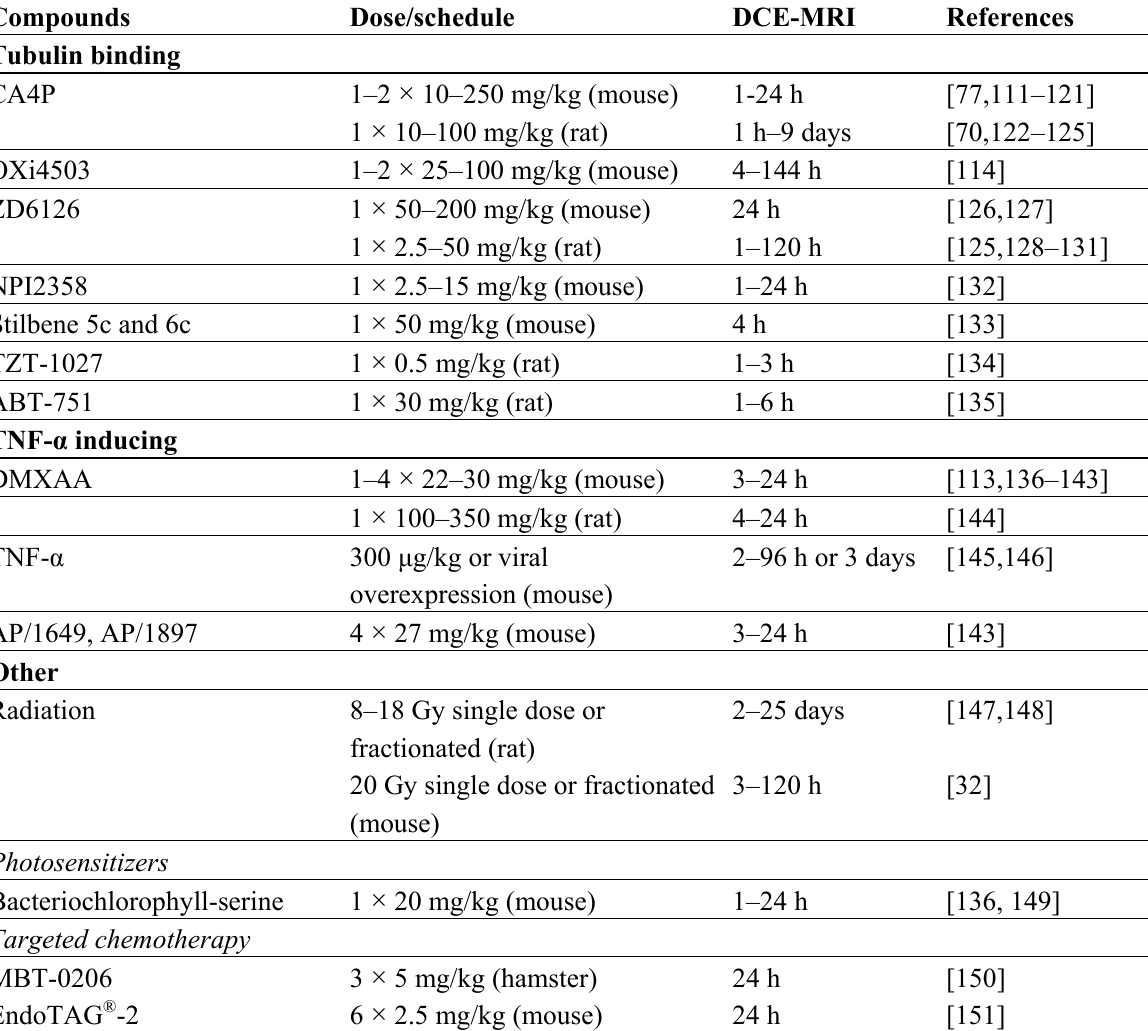
Table 2. Vascular disrupting